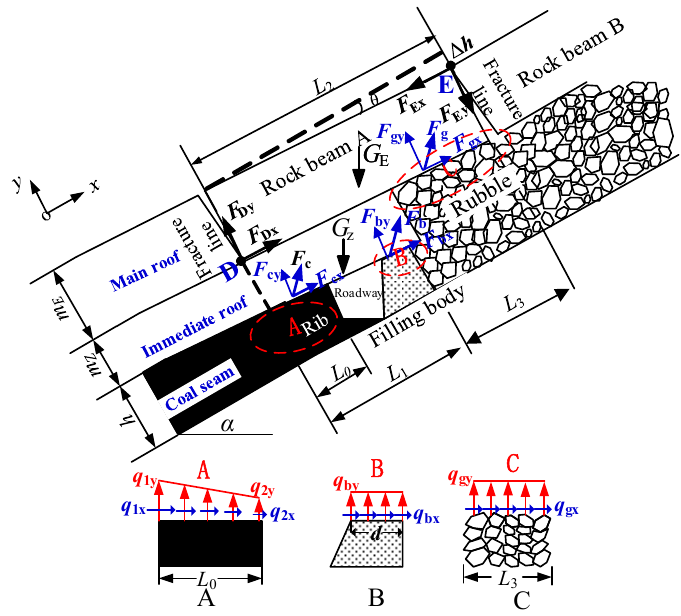
Figure 4. Mechanical model of roof of gob-side entry retention work in steeply inclined coal seam.